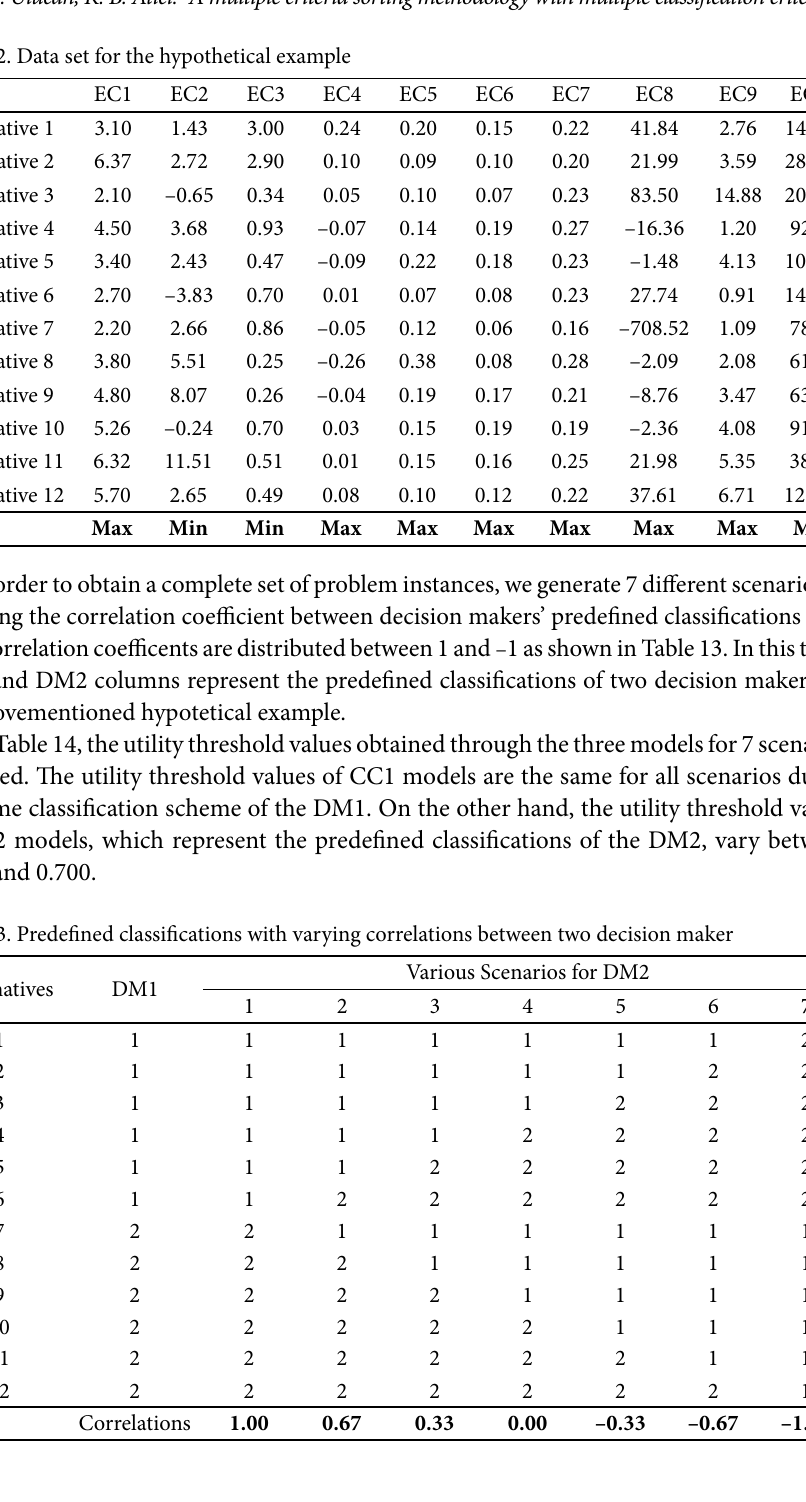
table 12. Data set for the hypothetical example